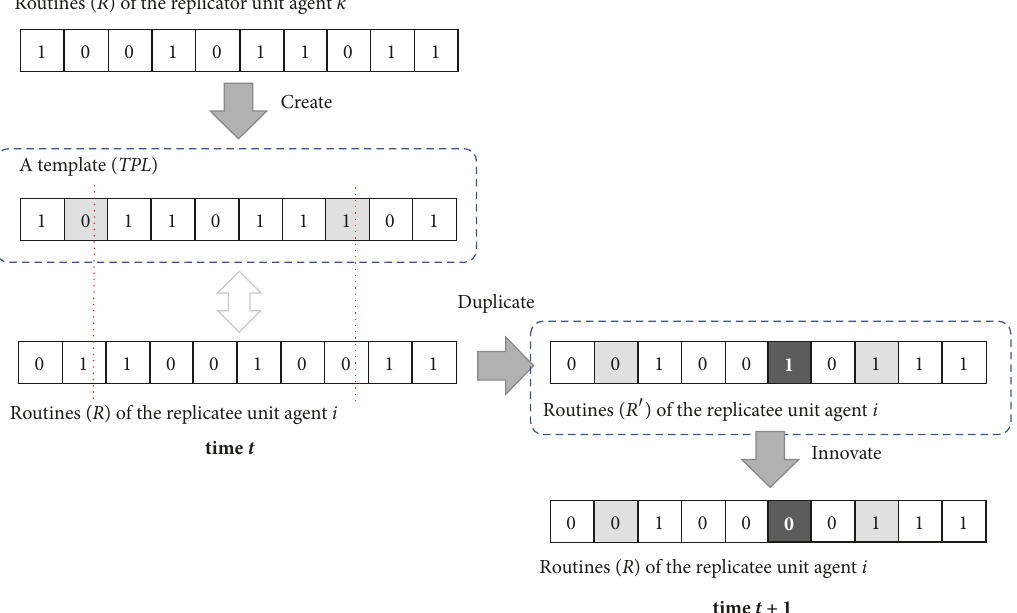
Figure 3: Mechanisms of replicating routines between unit agents ( unit AC =